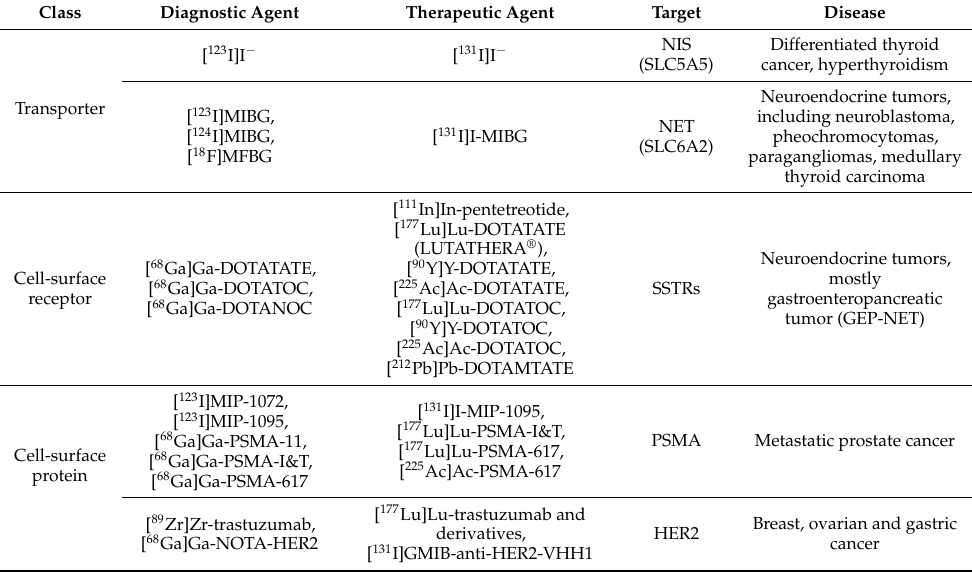
Table 1. Examples of theranostic